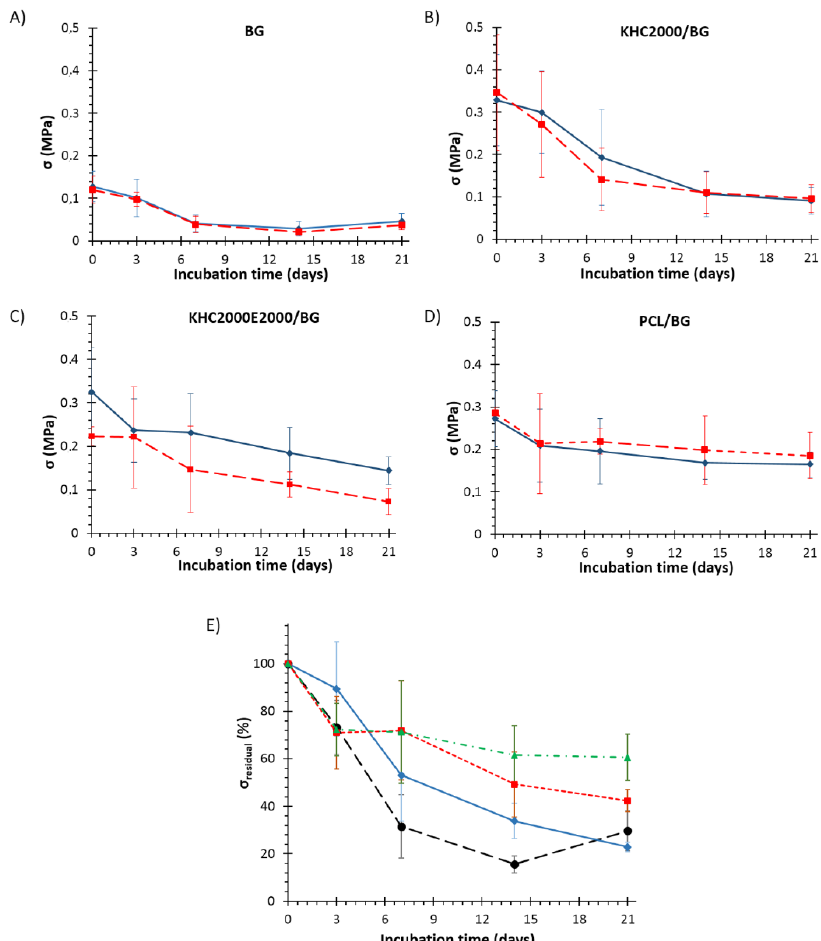
Figure 13. Trend of compressive strength evaluated in dry (blue, continuous line) and wet (red, dashed line) conditions as a function of immersion time in SBF for ( A ) BG, ( B ) KHC2000/BG, ( C ) KHC2000E2000/BG, and ( D ) PCL/BG scaffolds. ( E ) Change in compressive strength (σ residual (%)) calculated according to Equation (4), as a function of immersion time in SBF for BG (black, dashed line), PCL/BG (green, dashed-dotted line), KHC2000/BG (blue, continuous line) and KHC2000E2000/BG (red, dashed line) scaffolds.